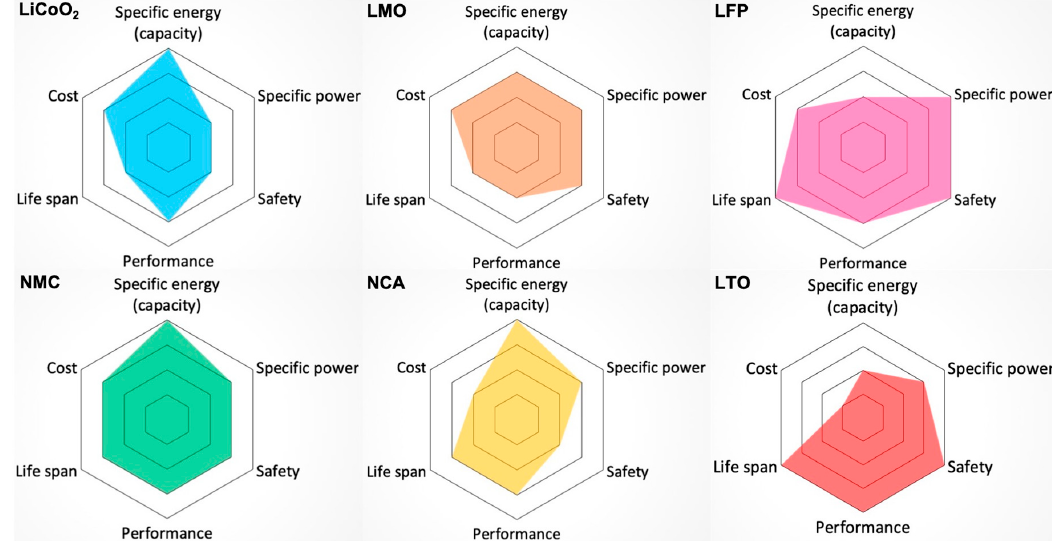
Figure 4. Comparisons of different types of Li-ion batteries used in EVs from the following perspectives: specific energy (capacity), specific power, safety, performance, life span, and cost (the outer hexagon is most desirable). Lithium Nickel Manganese Cobalt Oxide (NMC), Lithium Iron Phosphate (LiFePO 4 ) and Lithium Manganese Oxide stand out as being superior among these six candidates